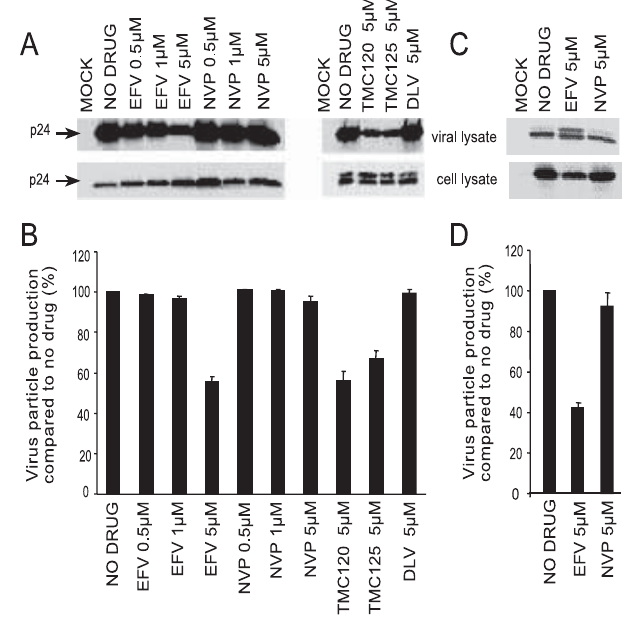
Figure 6. Potent NNRTIs Inhibit Viral Particle Production Viral particle production in drug-treated 293T cells (A) and in HeLa cells (C). Top panels represent virion-associated p24 and bottom panels are p24 present in cell lysates. Cells were transfected with pDRNL and treated with drug as described in Figure 3, except that after 36 h, cells were metabolically labeled with Trans[ 35 S]-label for 4 h. Cell lysates were immunoprecipitated using anti-CA mAb and viral particles in the supernatant were pelleted through a sucrose cushion. The proteins were separated by SDS-PAGE and visualized and quantified using a phosphorimager. Viral particle production in 293T cells (B) and HeLa cells (D) was quantified as described in Materials and Methods. Data represent at least three independent experiments and are expressed as the mean 6 standard error.